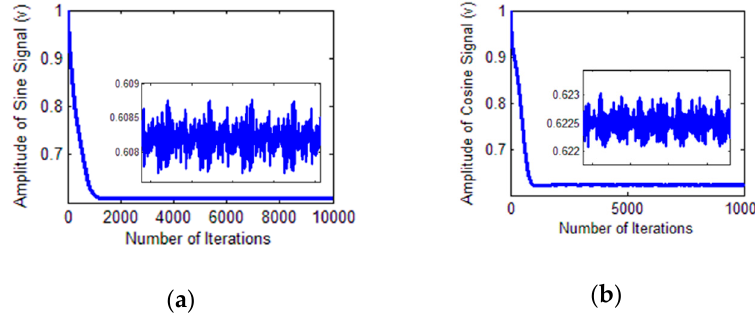
Figure 18. Identification process. ( a ) Amplitude of the sine signal; ( b ) amplitude of the cosine signal. The DC offset identification process is shown in Figure 19.